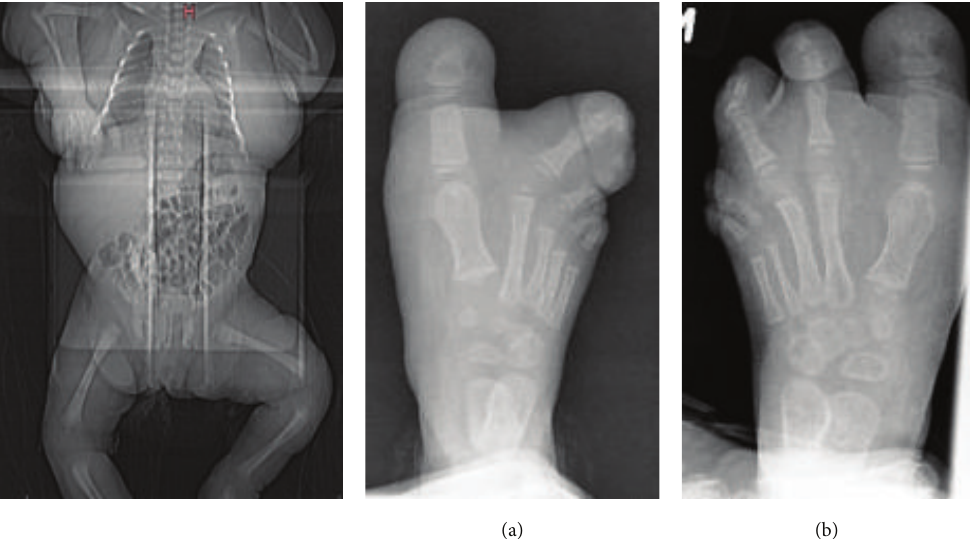
Figure 6: X-ray. (a) Right foot; (b) left foot.